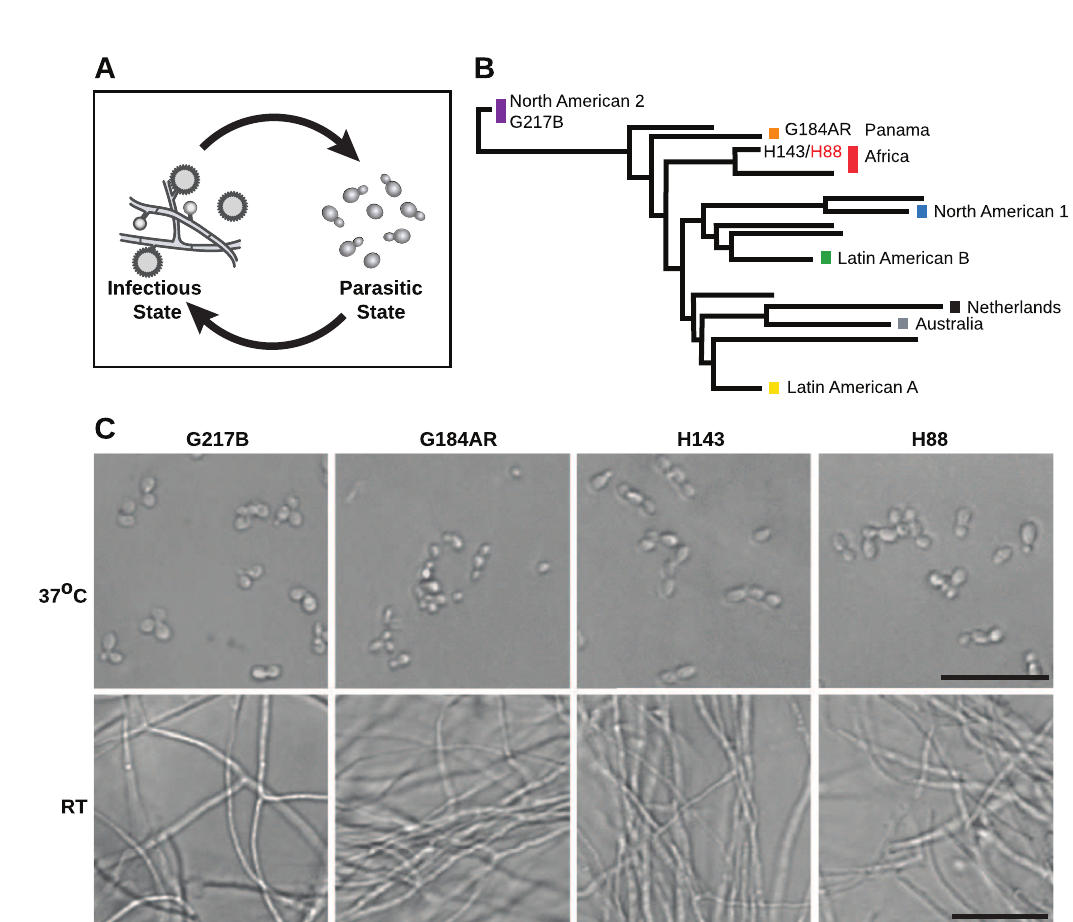
Fig 1. Histoplasma is a global human pathogen with distinct morphological states important for virulence. (A) Histoplasma hyphae and conidia (infectious state) respond to temperature to differentiate into budding yeast cells (parasitic state) inside of a mammalian host. (B) Phylogeny of Histoplasma illustrating the major lineages of this species, which are geographically and genetically distinct. This neighbor-joining tree was adapted from Katsuga et al. [7] and highlights Histoplasma strains selected for comparative transcriptomics (G217B, G184AR, H88, H143). H88 is highlighted in red as the Hc var. duboisii strain selected for transcriptome analysis. (C) Confocal DIC microscopy showing representative images of yeast (37˚C) and hyphal (RT) cell morphologies for the 4 Hc strains used for comparative transcriptomics analyses. Scale bar, 20 μ